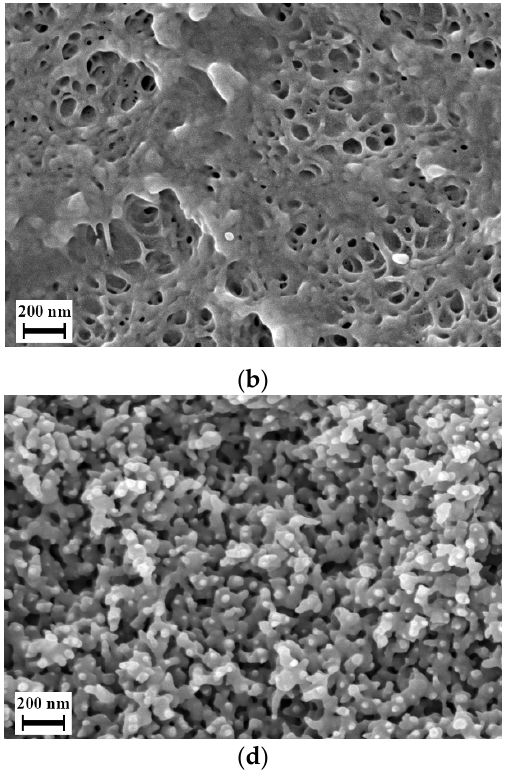
( f ) Figure 10. Scanning electron micrographs of sandwich-type samples manufactured using method I, batch foamed and post-treated: ( a ) Cross section of blend H-8; ( b ) Microstructure observed in the skin layer from figure a ; ( c ) Cross section of blend H-32; ( d ) microstructure observed in smaller green box and commonly found across the area enclosed by larger green boxes in figure c ; ( e ) Observed solid structure in the smaller red box and commonly found across the area enclosed by the larger red box in figure c ; ( f ) Outer surface of blend H-32. To overcome these issues, thinner blend samples were used in method II of preparing sandwich-type samples, and to ensure completely sealed covering of the blend layer, the PVP layer was compression molded instead. Since only blend H-32 delivered promising